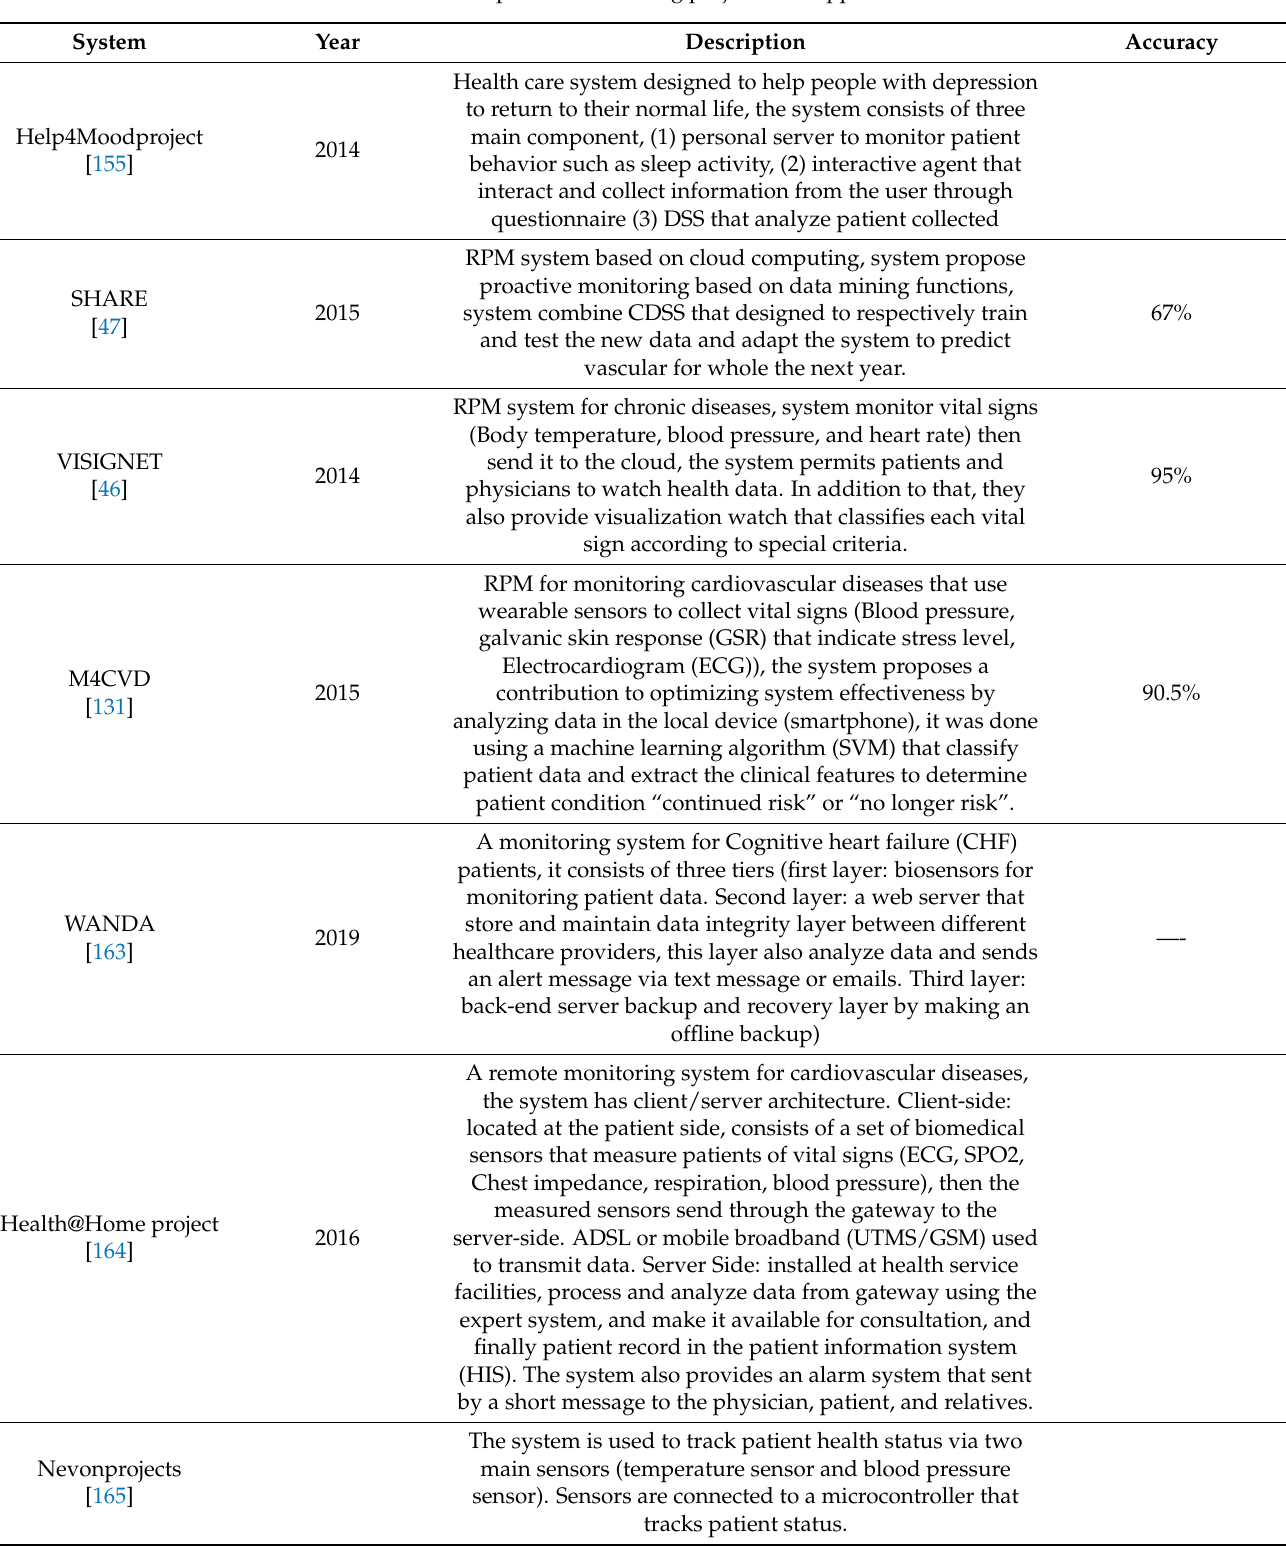
Table 8. Remote patient monitoring projects and